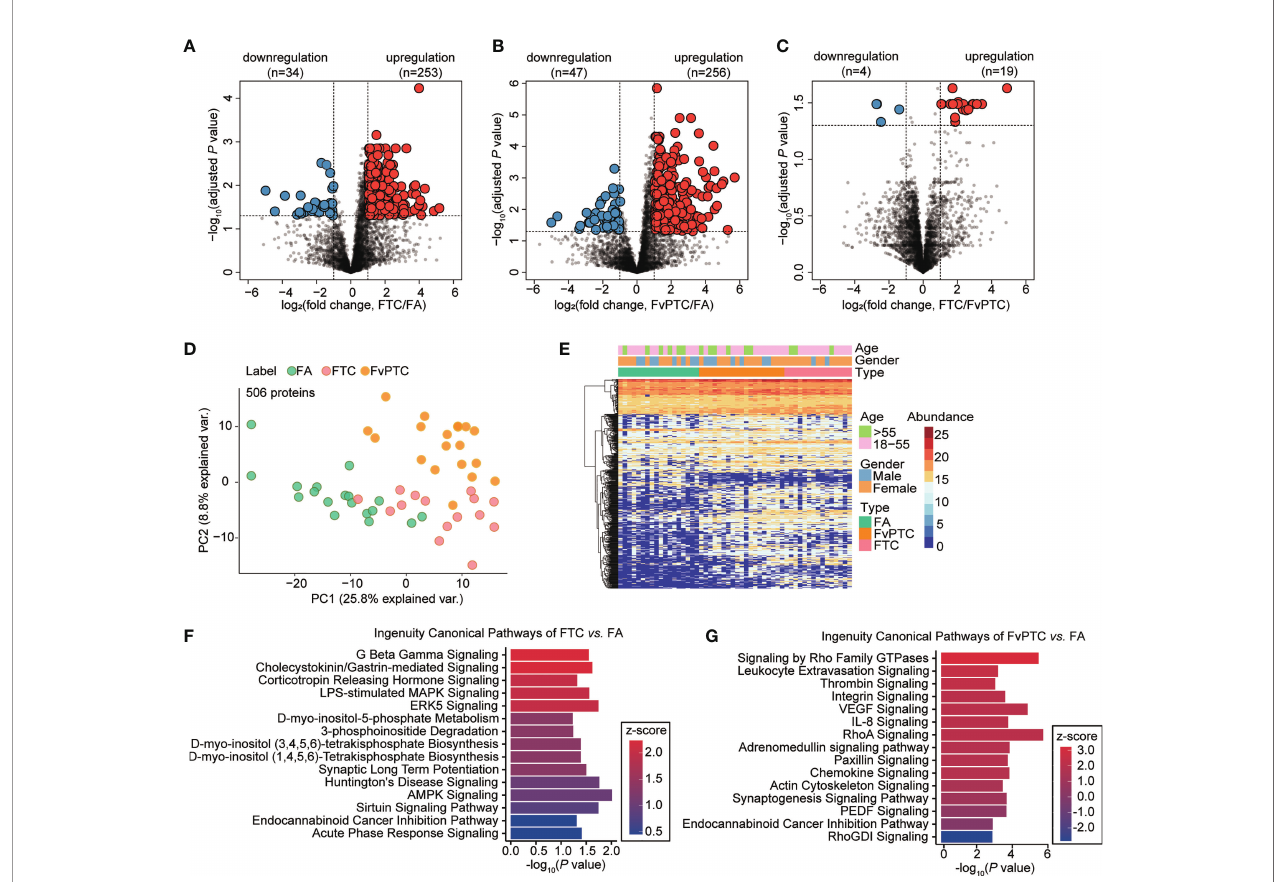
FIGURE 3 | Dysregulated protein expression analysis. (A-C) Volcano plot showing dysregulated proteins in (A) FTC vs. FA, (B) FvPTC vs. FA, and (C) FvPTC vs. FTC with a two-fold-change cutoff and an adjusted P value threshold less than 0.05. (D) PCA of samples from different tumor types using 506 dysregulated proteins. (E) Heatmap showing the protein expression pro fi les of 52 follicular-patterned thyroid tumor tissue specimens. 506 proteins (rows) are clustered without supervision. Samples (columns) are arranged based on the tissue type. The color indicates the log 2 -transformed intensity of each protein in each sample. Ingenuity canonical pathway analysis was used to enrich pathways from differentially expressed proteins (DEPs) in FTC vs. FA (F) and FvPTC vs. FA (G) . The top 15 enriched canonical pathways with P value <0.05 are ordered based on the z-score